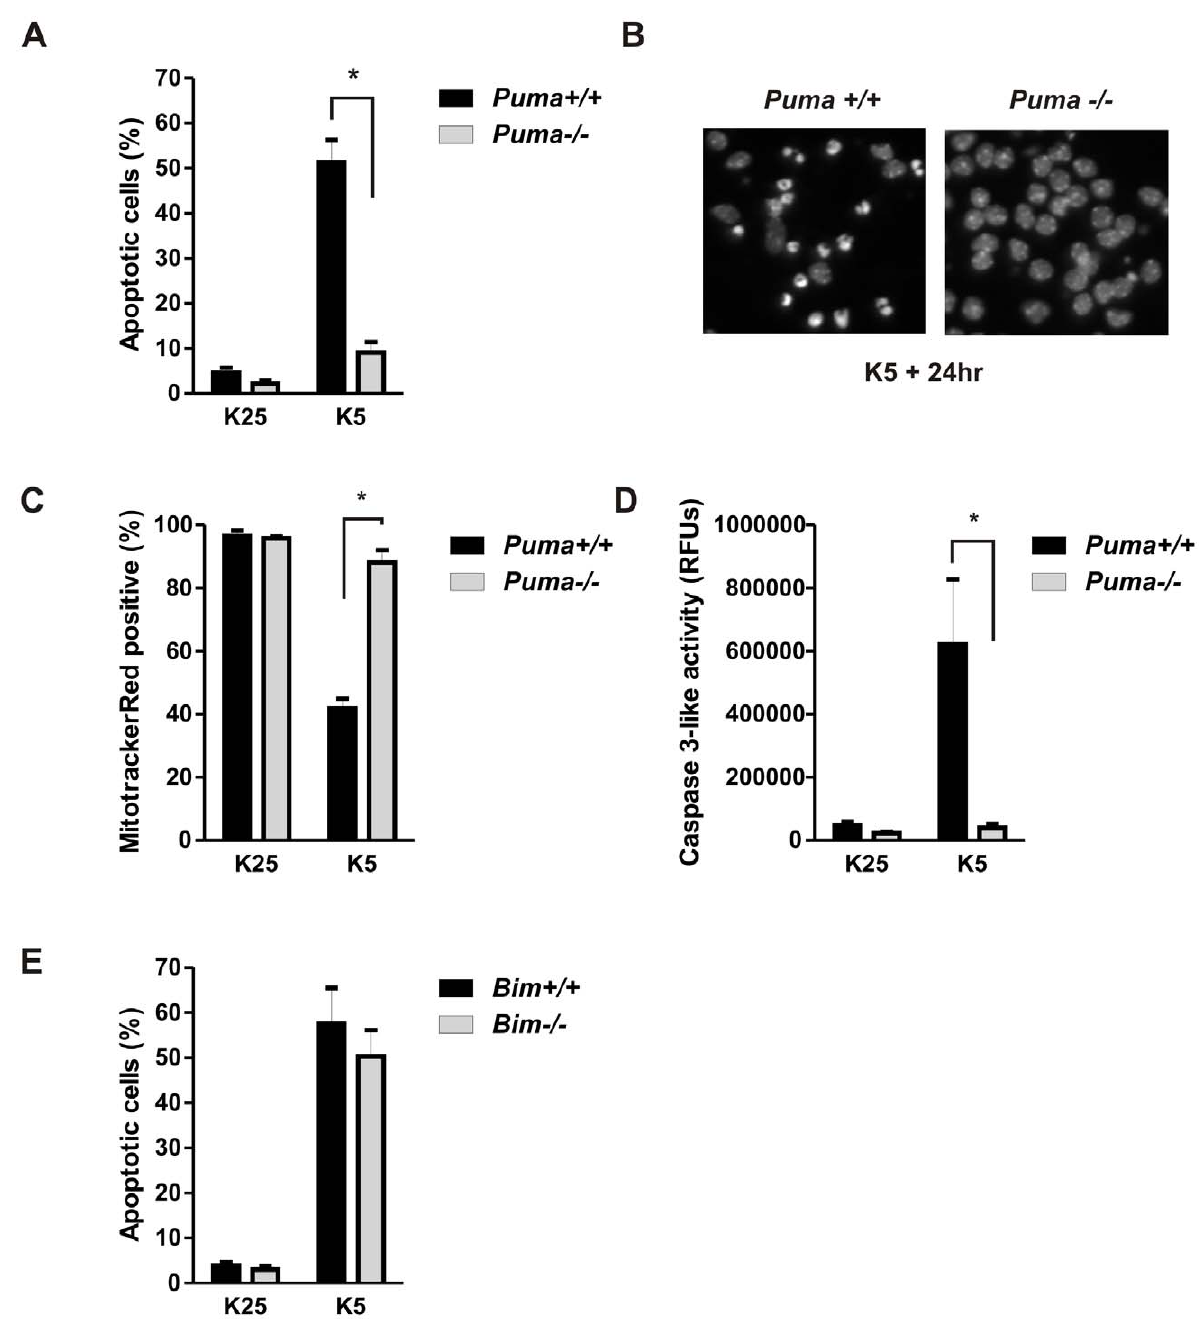
Figure 2. Puma is essential for potassium-withdrawal induced apoptosis in CGNs. CGNS derived Puma + / + and Puma 2 / 2 littermates were maintained in high potassium medium (K25) or switched to low potassium medium (K5). A, The fraction of apoptotic cells was determined at 24 h by assessing nuclear morphology following Hoechst staining of Puma + / + vs Puma 2 / 2 CGNs (n=7, *p , 0.01). B, Representative images of Hoechst stained wild type and Puma-deficient neurons 24 hours following potassium withdrawal. C, CGNs were stained with Mitotracker Red to assess mitochondrial membrane potential. The fraction of Mitotracker Red labeled neurons was determined 20 hours after potassium withdrawal and compared between genotypes (n=4, *p , 0.05). D, Cell lysates were collected 20 hours after potassium withdrawal and assayed for caspase-3-like activity. Caspase activity is reported as relative fluorescence units of cleaved caspase substrate and was compared between genotypes (n=4,* p , 0.05). E, CGNs derived from Bim + / + and Bim 2 / 2 littermates were maintained in high potassium medium or switched to low potassium medium and the fraction of apoptotic cells was determined at 24 h (n=5). doi:10.1371/journal.pone.0046885.g002 inhibitor AR-A014418 [54,55]. As shown in Figures 7A and 7B, GSK3 b inhibition also significantly reduced the level of apoptosis the induction of Puma mRNA and protein by potassium induced by potassium deprivation (Figure 7C). We next examined deprivation was significantly reduced by the GSK3 b inhibitors. the role of GSK3 b in Puma expression and cell death induced by